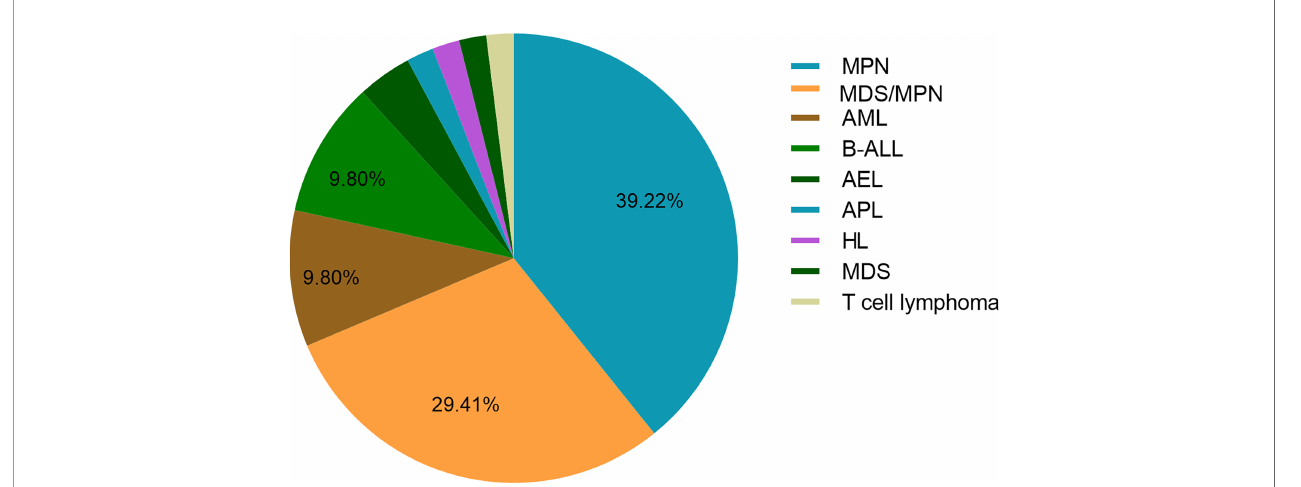
FIGURE 2 | Distribution of PCM1-JAK2 fusion in hematological neoplasms in the literature. MPNs, myeloproliferative neoplasms; MDS/MPN, myelodysplastic syndrome/myeloproliferative neoplasms; AML, acute myeloid leukemia; B-ALL, B-cell acute lymphoblastic leukemia; AEL, acute erythroid leukemia; APL, acute promyelocytic leukemia; HL, Hodgkin